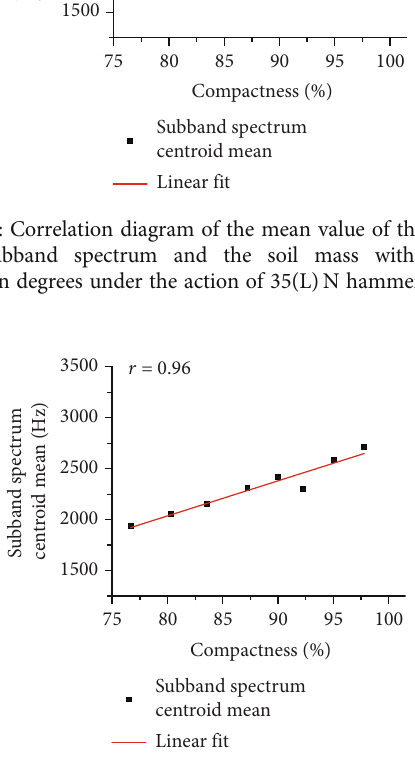
Figure 16: Correlation diagram of the mean value of the centroid of the subband spectrum and the soil mass with di ff erent compaction degrees under the action of 45(L) N hammering force.